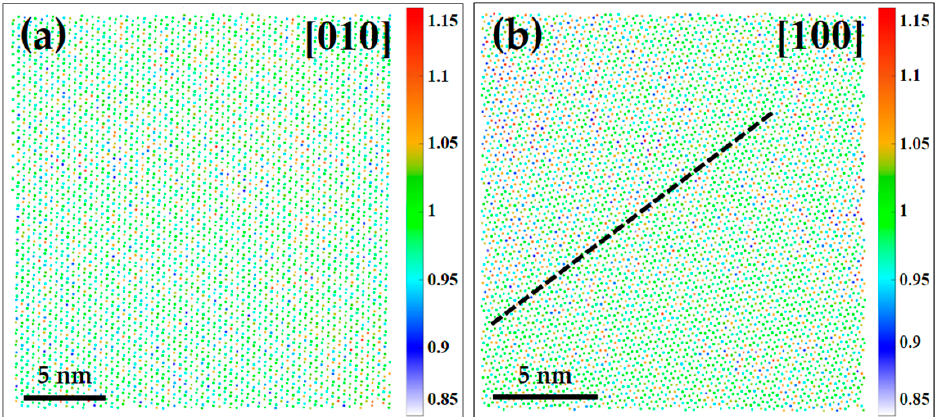
Figure 7. The normalized intensity mapping of STEM-HAADF images (as shown in Figure 5c,d) along the [010] ( a ) and [100] ( b ) directions, respectively. The normalized intensity mapping with different colors reflects the relative concentration of radiogenic Pb and Th in each column. The average value of brightness is set to be 1.0 (green, as shown in the mapping and color bar). Blue-to-white with a value of 0.85 represents the distribution of rare earth elements (REEs) where Pb and Th is poor. Red-yellow with a value of 1.15 represents the distribution of Pb-rich and Th-rich in the column.